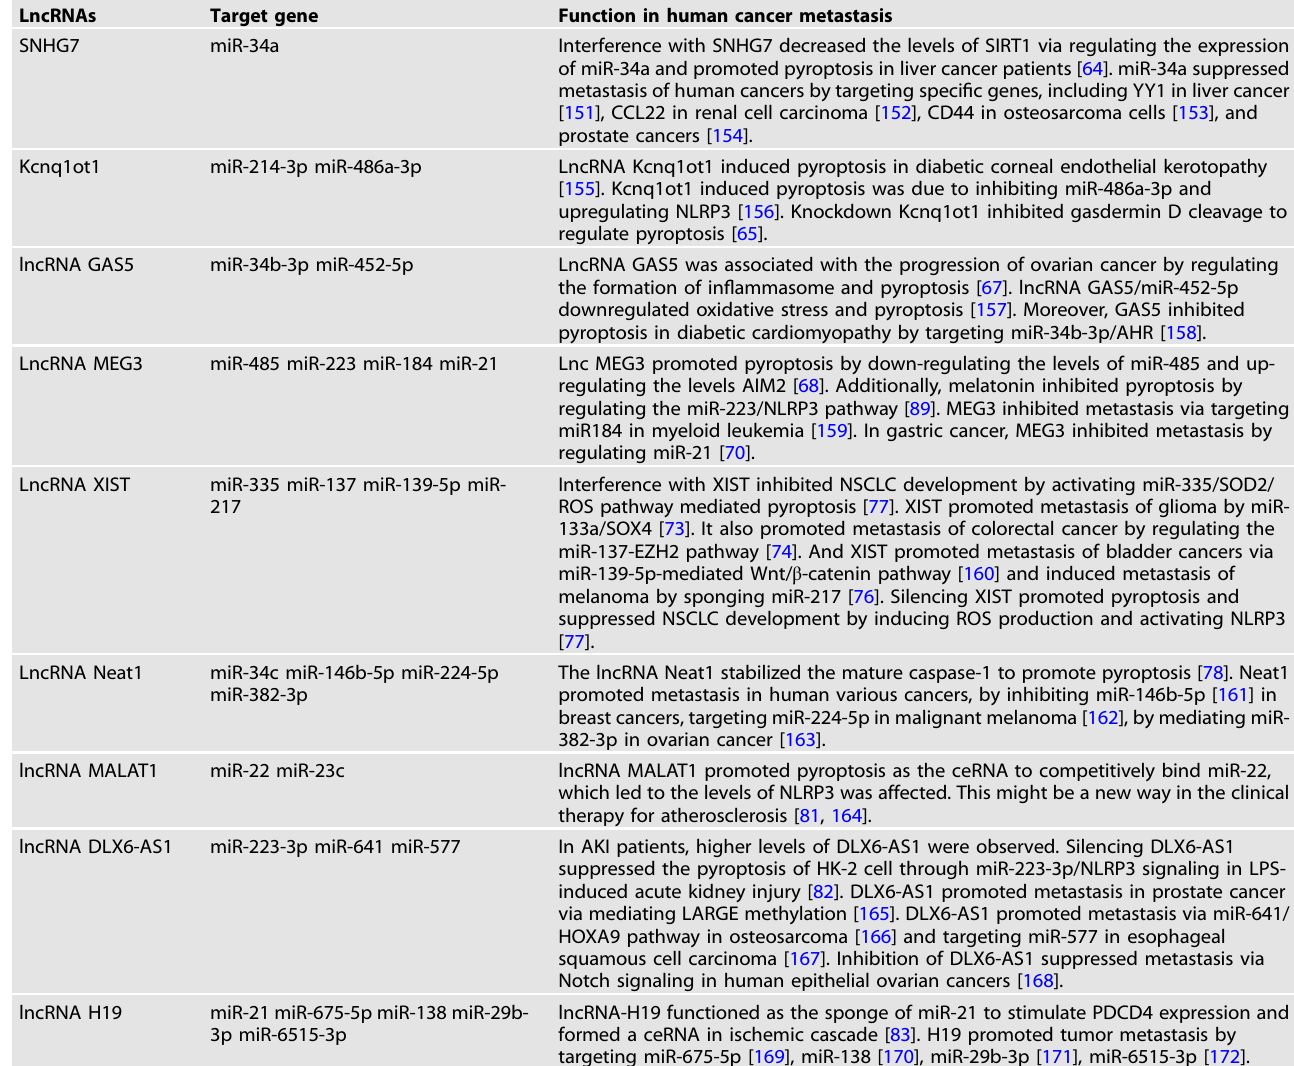
Table 2. Noncoding RNAs regulates pyroptosis in cancer metastasis. LncRNAs Target gene Function in human cancer